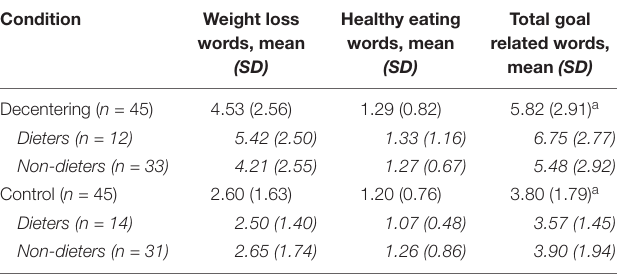
TABLE 2 | Number of weight loss and healthy eating related words generated by dieting and non-dieting participants in the decentering and control